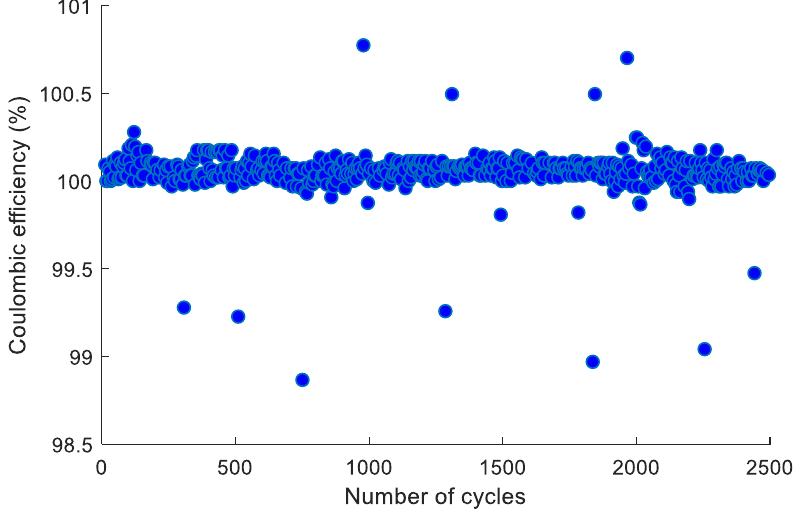
Figure 15. Relationship between the number of cycles and Coulombic efficiency.